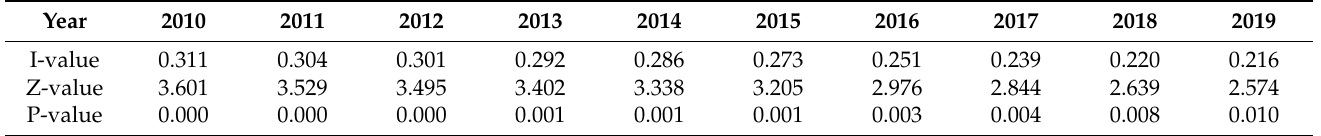
Table 3. Moran’s I Index of carbon emissions in southwest China from 2010 to